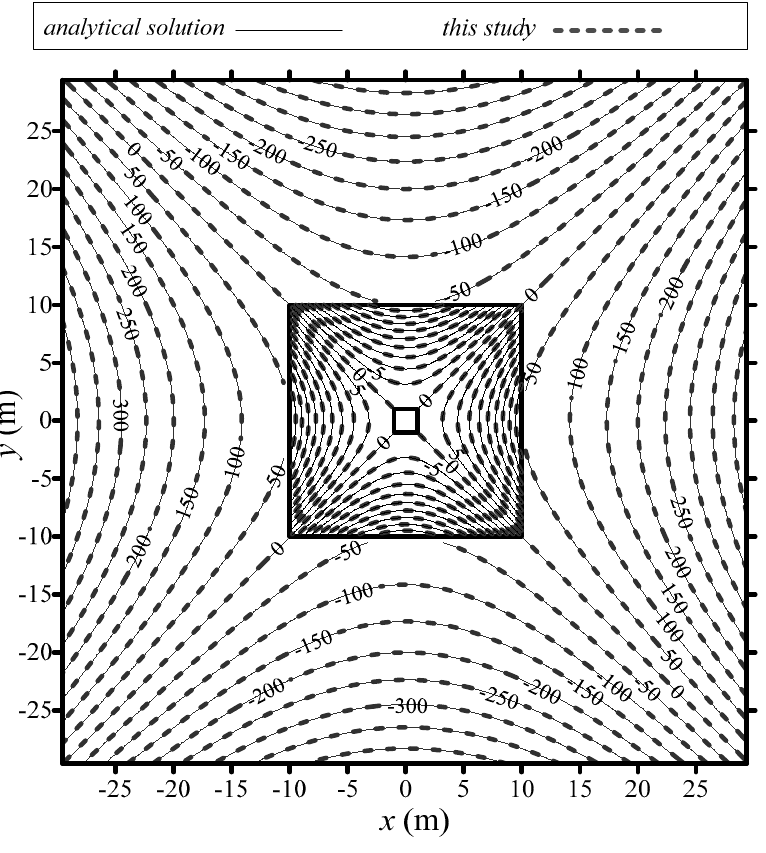
Figure 17. The comparison of temperature distribution with the analytical solution.